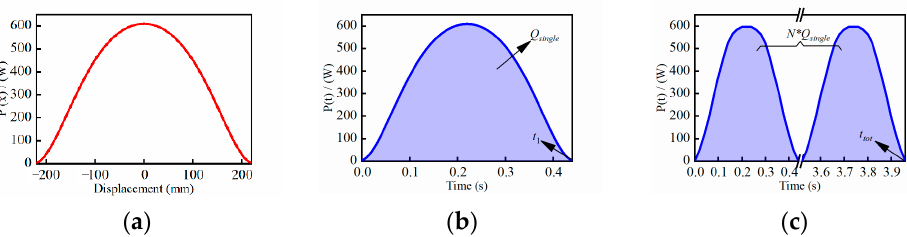
Figure 5. ( a ) Relationship between P ( x ) with displacement. ( b ) Relationship between P ( t ) with time. ( c ) Power fluctuation curve as the system passes through the charging road.